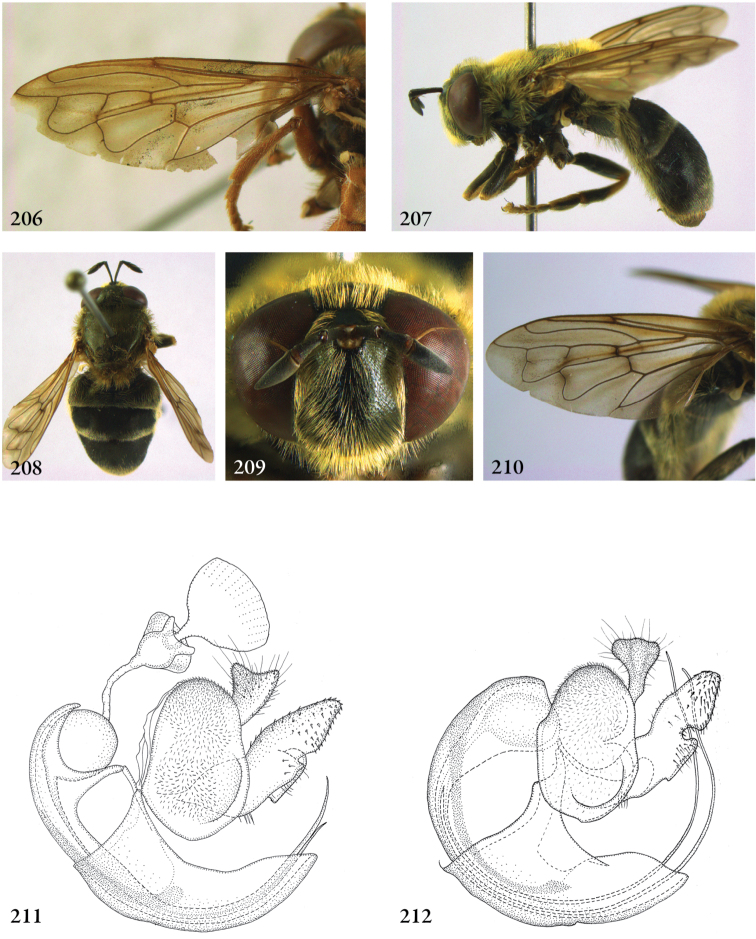
206
Microdon (Microdon) mandarinus male (holotype), wing 207–210
Microdon (Microdon) yunnanensis male (holotype) 207 habitus lateral 208 habitus dorsal 209 head frontal 210 wing 211–212
Microdon (Microdon), male genitalia: 211
Microdon mutabilis (Belarus, coll. M. Reemer) 212
Microdon hauseri (holotype).